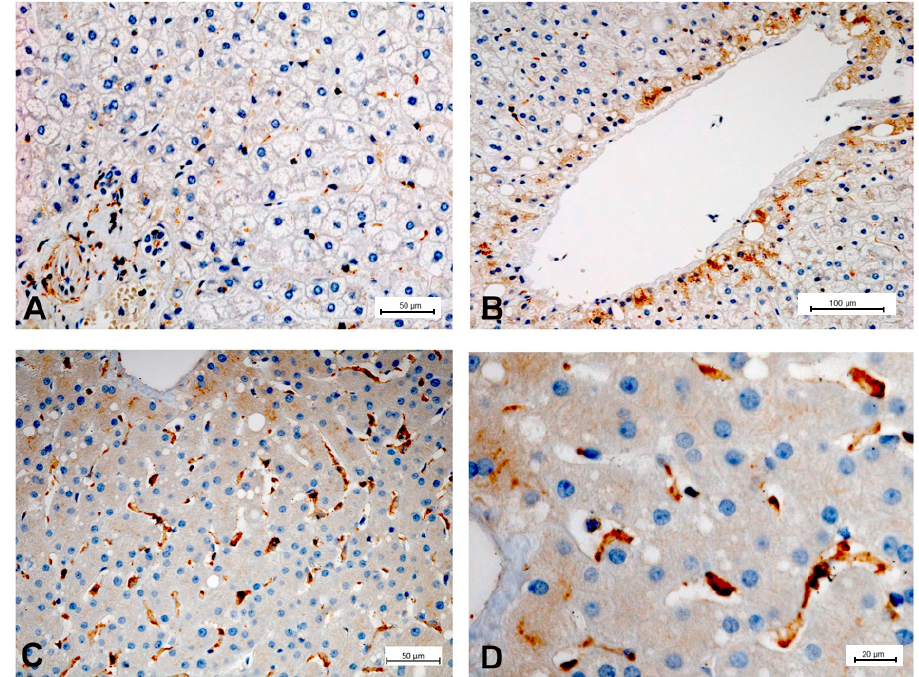
Figure 4. PDE-5 expression in healthy human liver tissue. Immunostaining for PDE-5 highlights portal tract vascular smooth muscle cells and myofibroblasts and shows reactivity of scattered sinusoidal lining cells in zone 1 and 2 ( A ). PDE-5 expression is enhanced in the cytoplasm of hepatocytes adjacent to terminal hepatic venules ( B ) and in zone 3 sinusoidal lining cells ( C , D